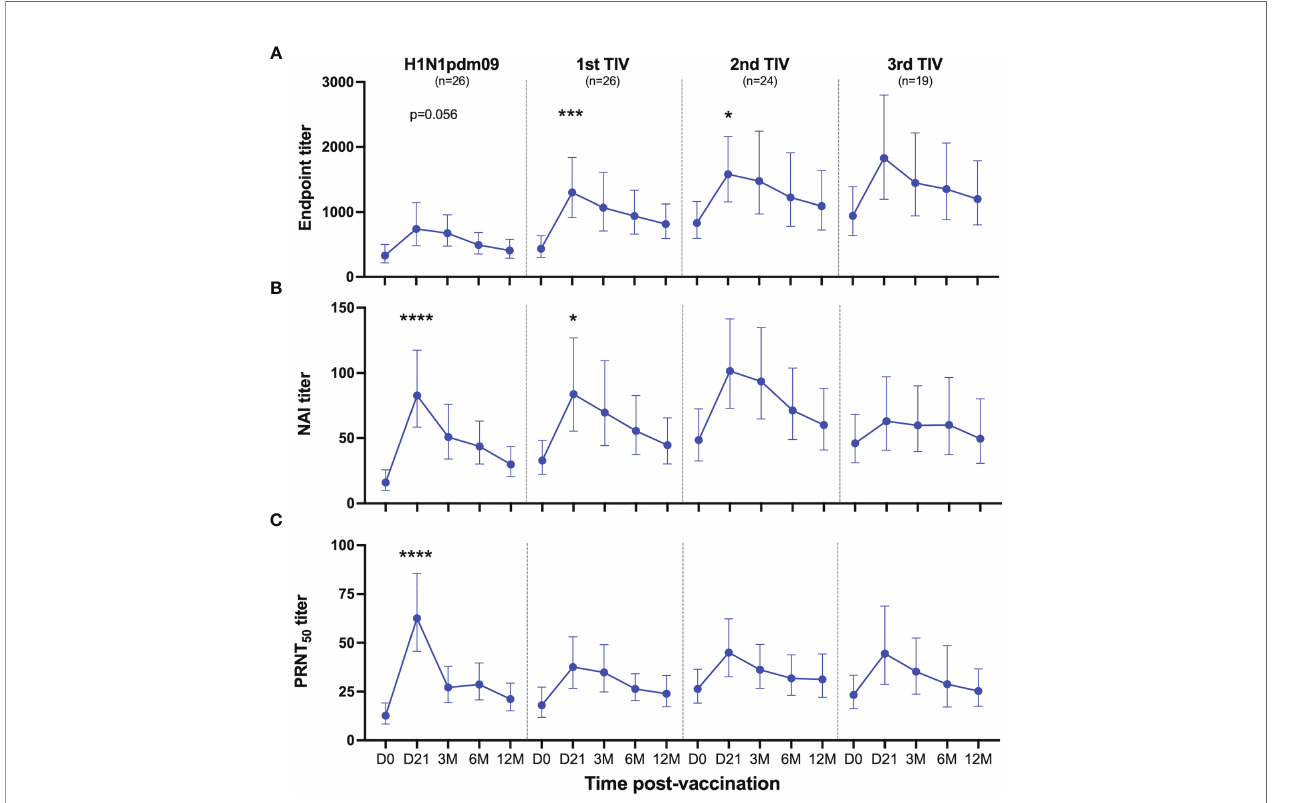
FIGURE 3 | Antibody responses to NA induced by H1N1pdm09 and TIV vaccination. Health care workers in the repeated group received two or three trivalent in fl uenza vaccines (TIV) in the four subsequent seasons after the 2009 pandemic during the fi ve-year study. Blood samples were collected pre-season (D0) and 21 days, 3, 6 and 12 months (D21, 3M, 6M, 12M, respectively) after each vaccination. Antibody responses were measured by ELISA (A) , ELLA (B) and plaque reduction neutralization assay (C) after vaccination with H1N1pdm09 and the fi rst, second or third TIV. All vaccinated HCWs in the repeated group is included in this fi gure regardless of their vaccination intervals. Data are shown as geometric mean with 95% con fi dence intervals. A linear mixed effects model with adjustments for demographic factors was used to determine statistical difference between antibody titers measured on day 0 and day 21 for each vaccination. *P ≤ 0.05, ***P ≤ 0.001, ****P ≤